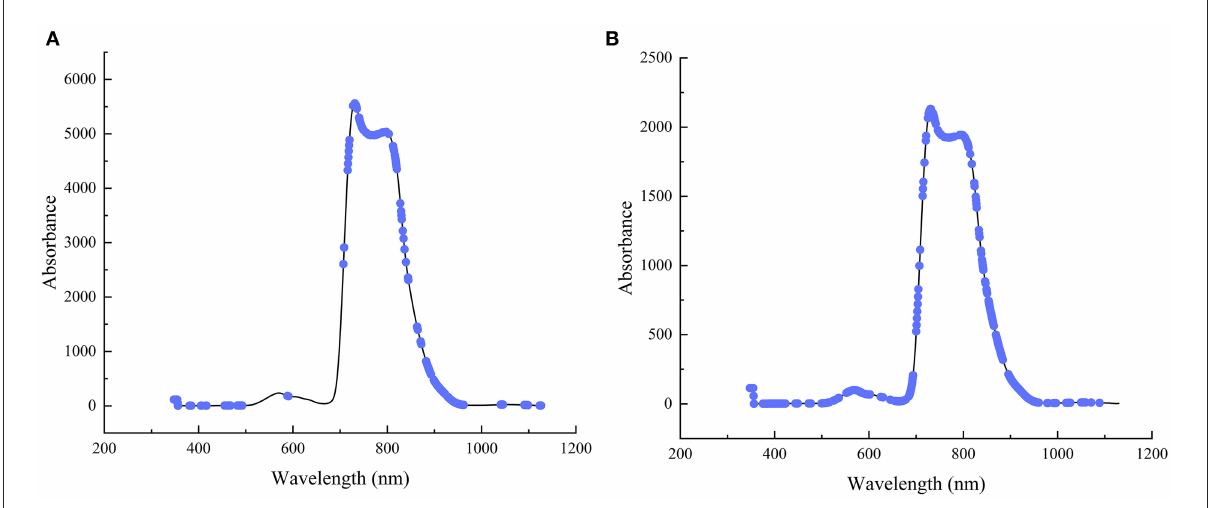
FIGURE3 (A) Variable optimization results with MCUVE for static detection; (B) Variable optimization results with MCUVE for online